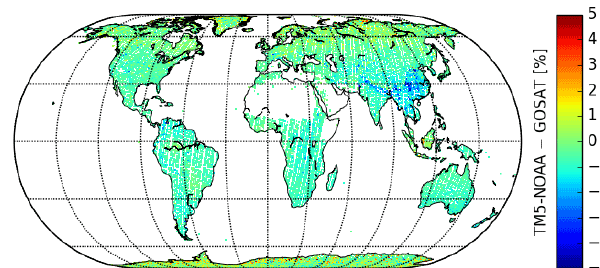
Figure 8. Difference between CH 4 total column dry air mixing ra- tios from TM5-NOAA simulations and GOSAT retrievals for the period June 2009 to December 2012.